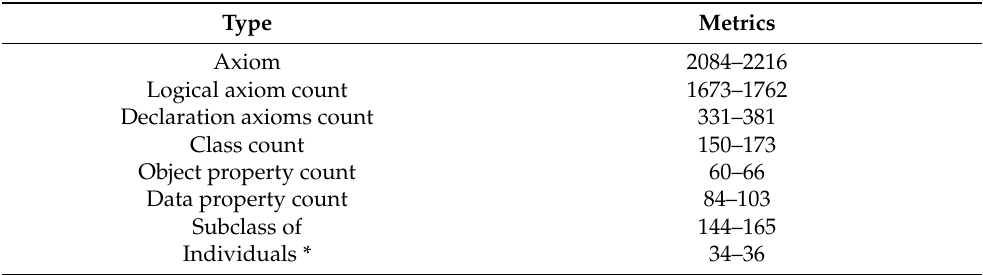
Table 4. Ontology metrics. * Individuals represent persons with manipulated values. Their gender and exact numbers does does not match actual values obtained in the data acquisition process. No subject had the same numbers e.g., number 107 and 109 etc. does not exist in the